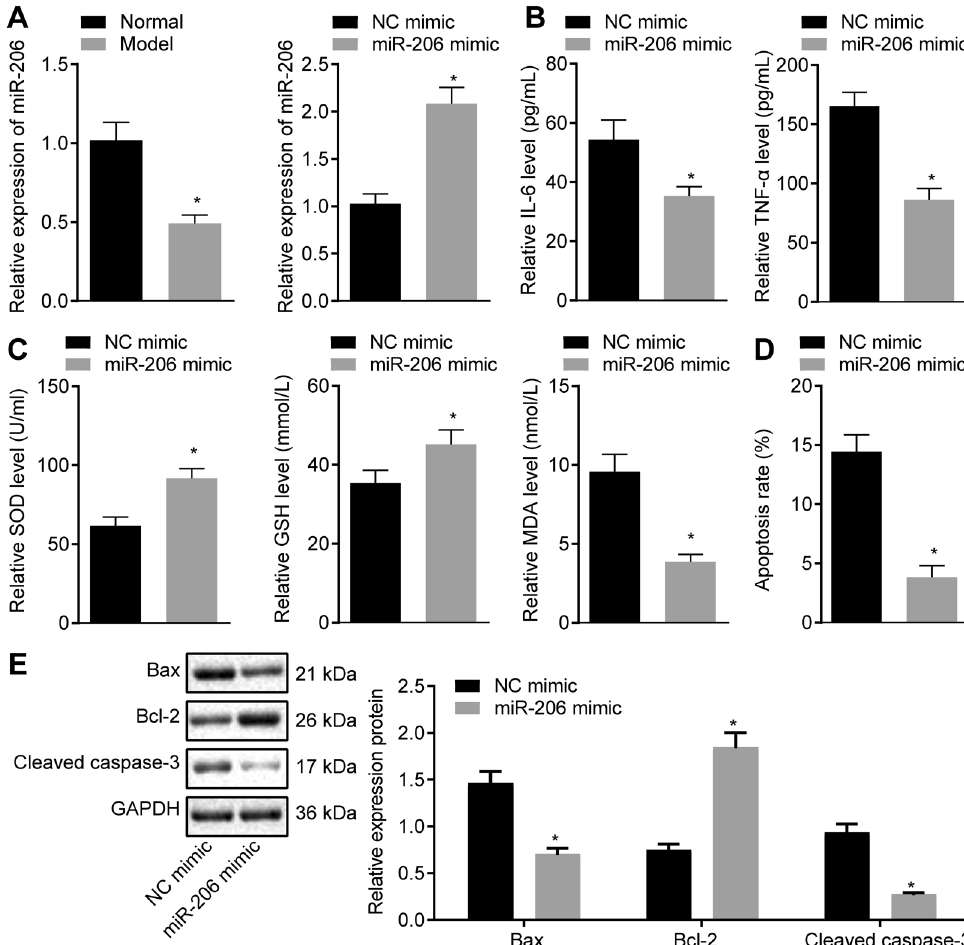
Fig. 3 miR-206 is poorly expressed in the cardiomyocytes of rats with MIRI and its overexpression prevents cardiomyocytes from IRI in vitro. A Expression of miR-206 in cardiomyocytes determined by RT-qPCR, normalized to U6. B The levels of in fl ammatory factors (IL-6 and TNF- α ) in cardiomyocytes detected by ELISA. C The levels of SOD, GSH, and MDA in cardiomyocytes. D Apoptosis of cardiomyocytes detected by fl ow cytometry. E Protein expression of Bax, cleaved Caspase-3, and Bcl-2 in cardiomyocytes determined by western blot analysis, normalized to GAPDH. * p < 0.05 vs. the normal cardiomyocytes or the cardiomyocytes transfected with NC-mimic. Data were all measurement data and expressed as mean ± standard derivation. Comparisons between two groups were analyzed by unpaired t- test. The experiment was conducted three times